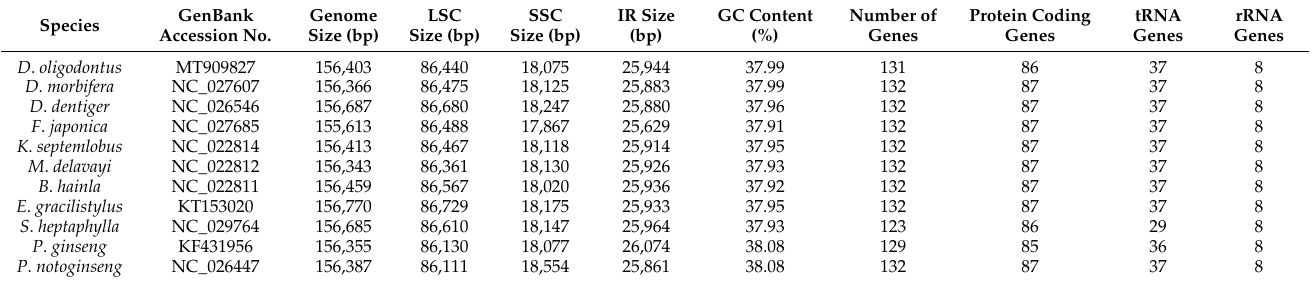
Table 4. Summary of the complete chloroplast genome characteristics of 11 Araliaceae